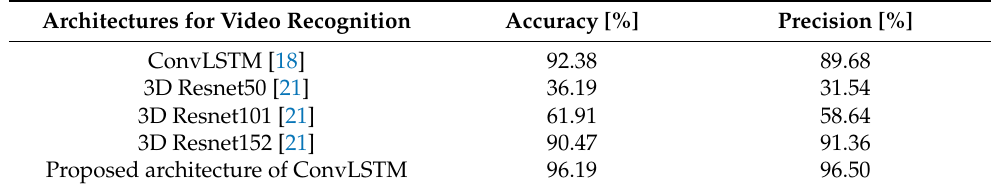
Table 9. Comparison of accuracy obtained by different neural network architectures using our dataset.